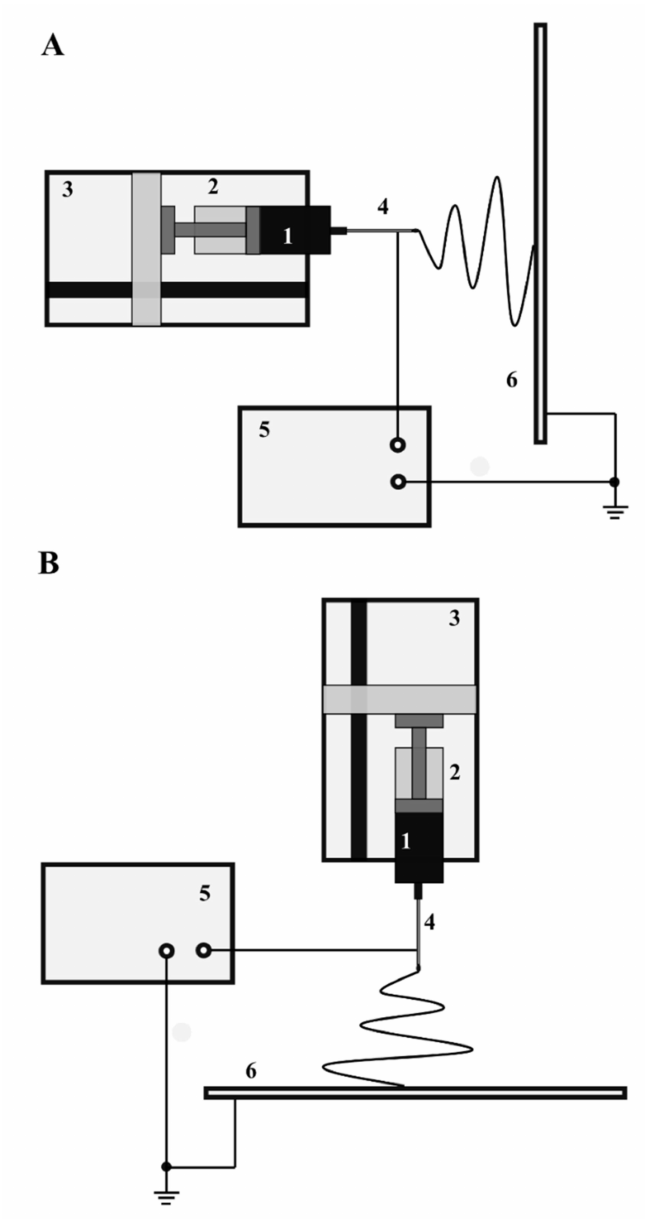
Figure 2. Horizontal ( A ) and vertical ( B ) arrangement for electrospinning process (1—polymer solution, 2—syringe. 3—syringe pump, 4—capillary (spinneret), 5—high voltage power supply, 6—collector) (own